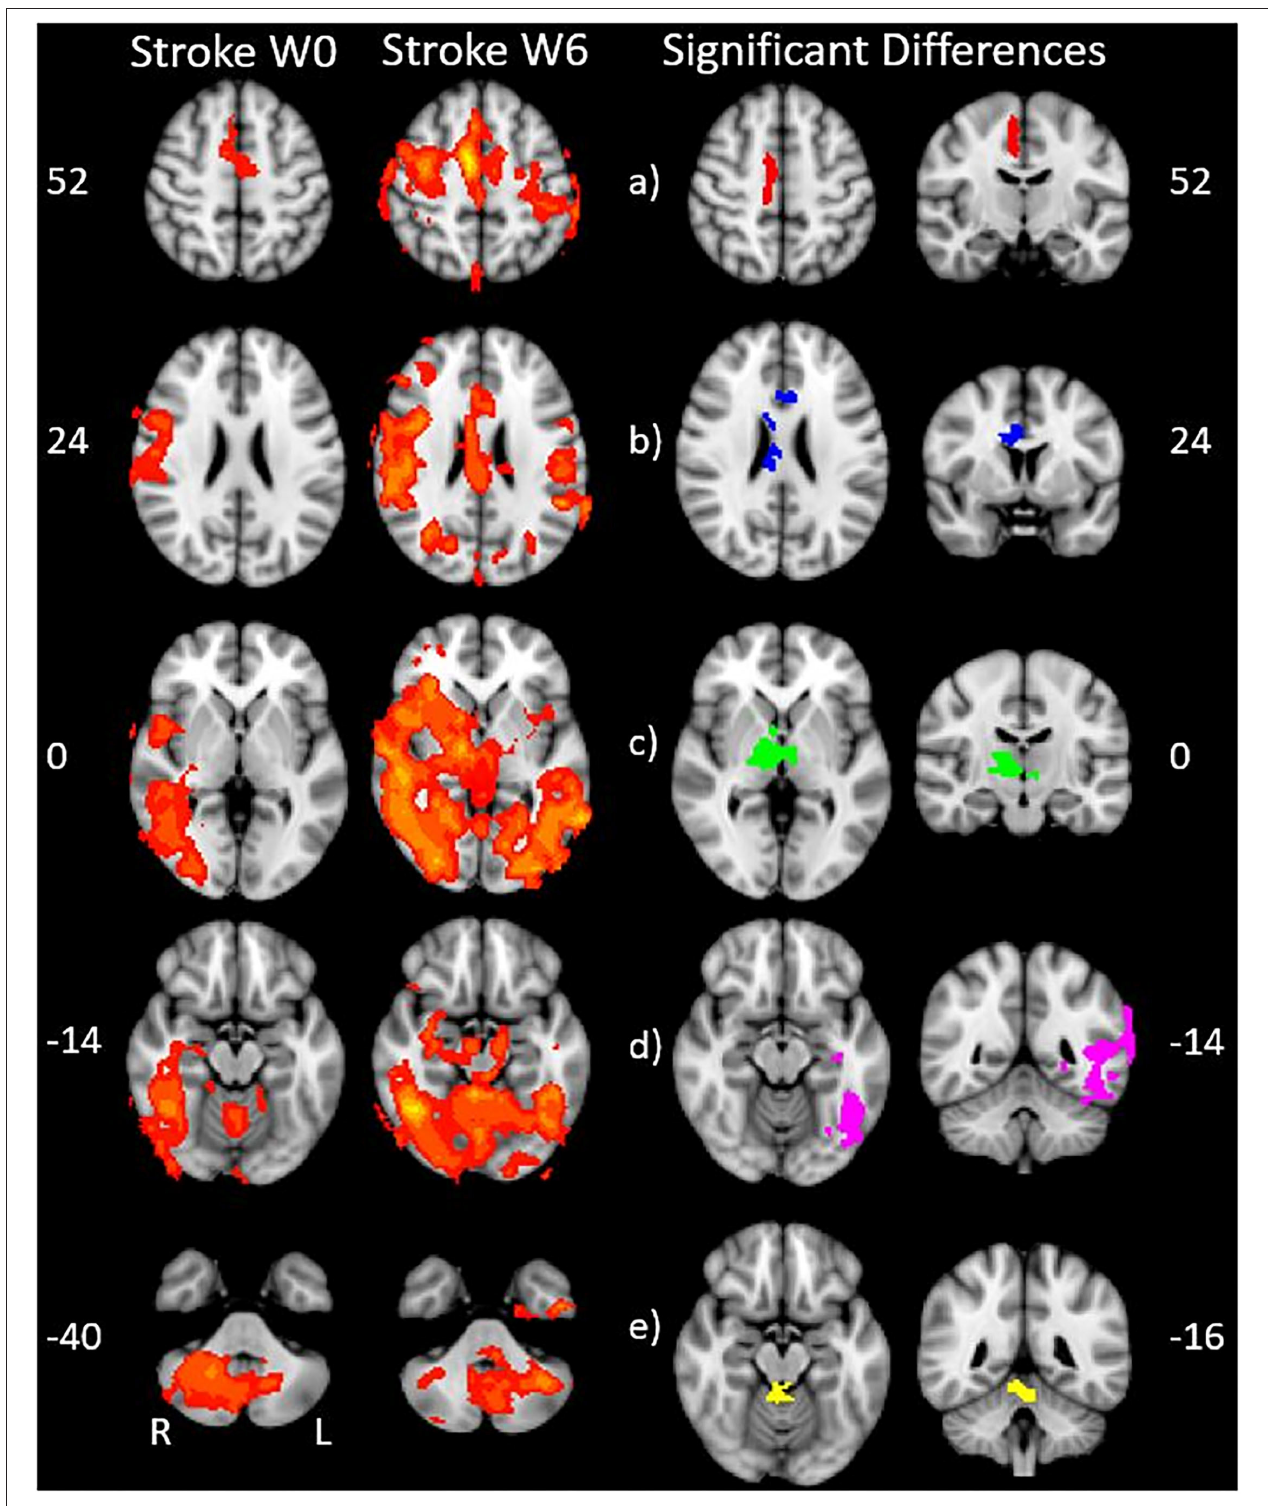
FIGURE 5 | Stroke differences during BoNT-A injections. The first two columns show significant ( p < 0.05) levels of activity across the stroke group for W0 (left) and W6 (right). Columns 3 and 4 show the coronal (left) and axial (right) view of significant increase in activity following the BoNT-A intervention, displayed as five regions of interests. These areas are: (a) right premotor cortex (b) right cingulate gyrus (c) right thalamus (d) sensory integration area, (e) superior cerebellum. The physical coordinates of the axial slices are shown to the left or right of axial images, and the coronal views are denoted by the yellow horizontal lines.